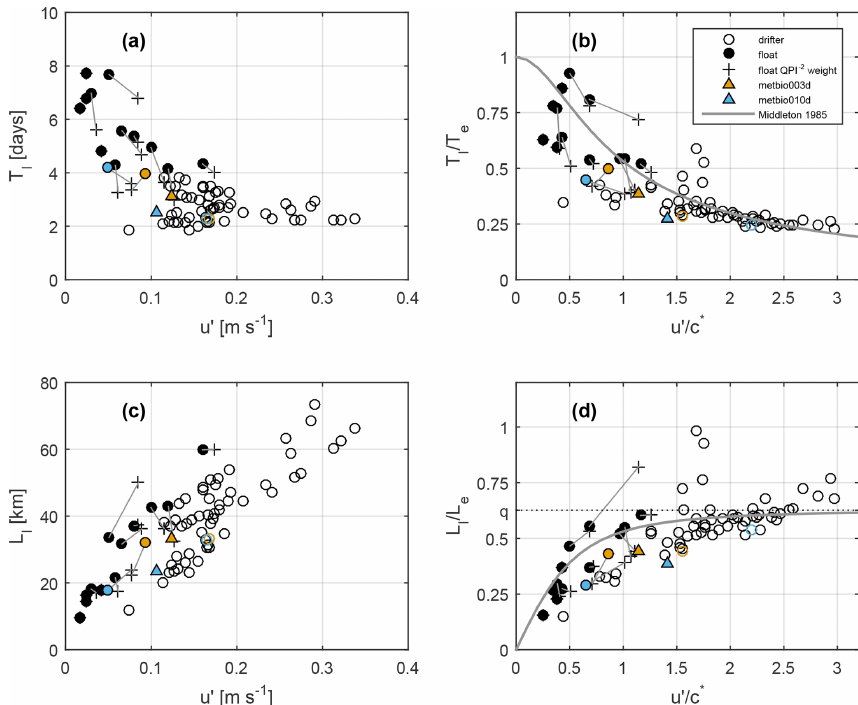
Figure 5. Scatter plots of velocity time and length scales for Lagrangian ( T l and L l ) and Eulerian ( T e and L e ) frames: (a) T l as a function of scale for the mesoscale eddy velocities, u (cid:48) ; (b) T l /T e as a function of u (cid:48) /c ∗ , where c ∗ is the evolution speed for the eddy field, and c ∗ = L e /T e ; (c) L l as a function of u (cid:48) ; and (d) L l /L e as a function of u (cid:48) /c ∗ . Hollow (filled) circles come from all surface drifters (all Bio- Argo floats) in a 5 ◦ × 5 ◦ bin, and crosses weight the Bio-Argo float-derived scales by QPI − 2 , with light grey lines connecting the weighted and unweighted values. Coloured triangles come from two time segments from two floats (metbio003d – orange; metbio010d – blue) with frequent and shallow profiling. The float and drifter circles coloured in the same manner are scales corresponding to the 5 ◦ × 5 ◦ bins hosting those two segments. The solid line indicates the theoretical relation of Middleton